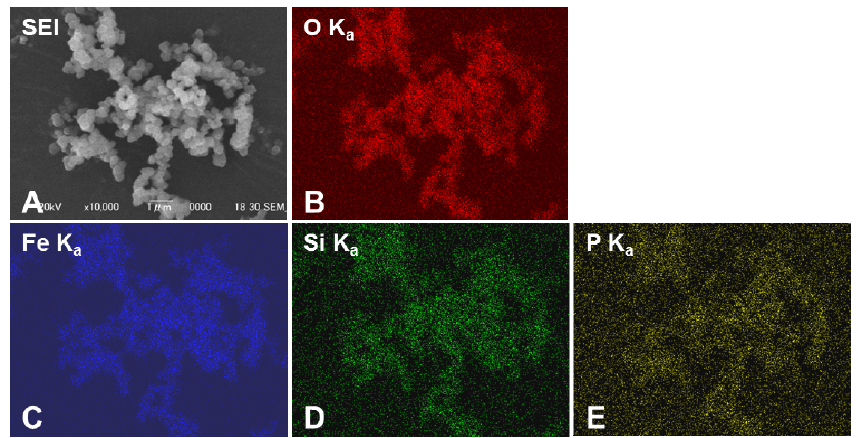
Figure A1. SEM-EDX analysis of particles assembling at discrete sites along the OUMS1 sheaths harvested after 7 days of culture in natural groundwater. ( A ) SEM image; ( B – E ) Distribution maps of O, Fe, Si, and P,